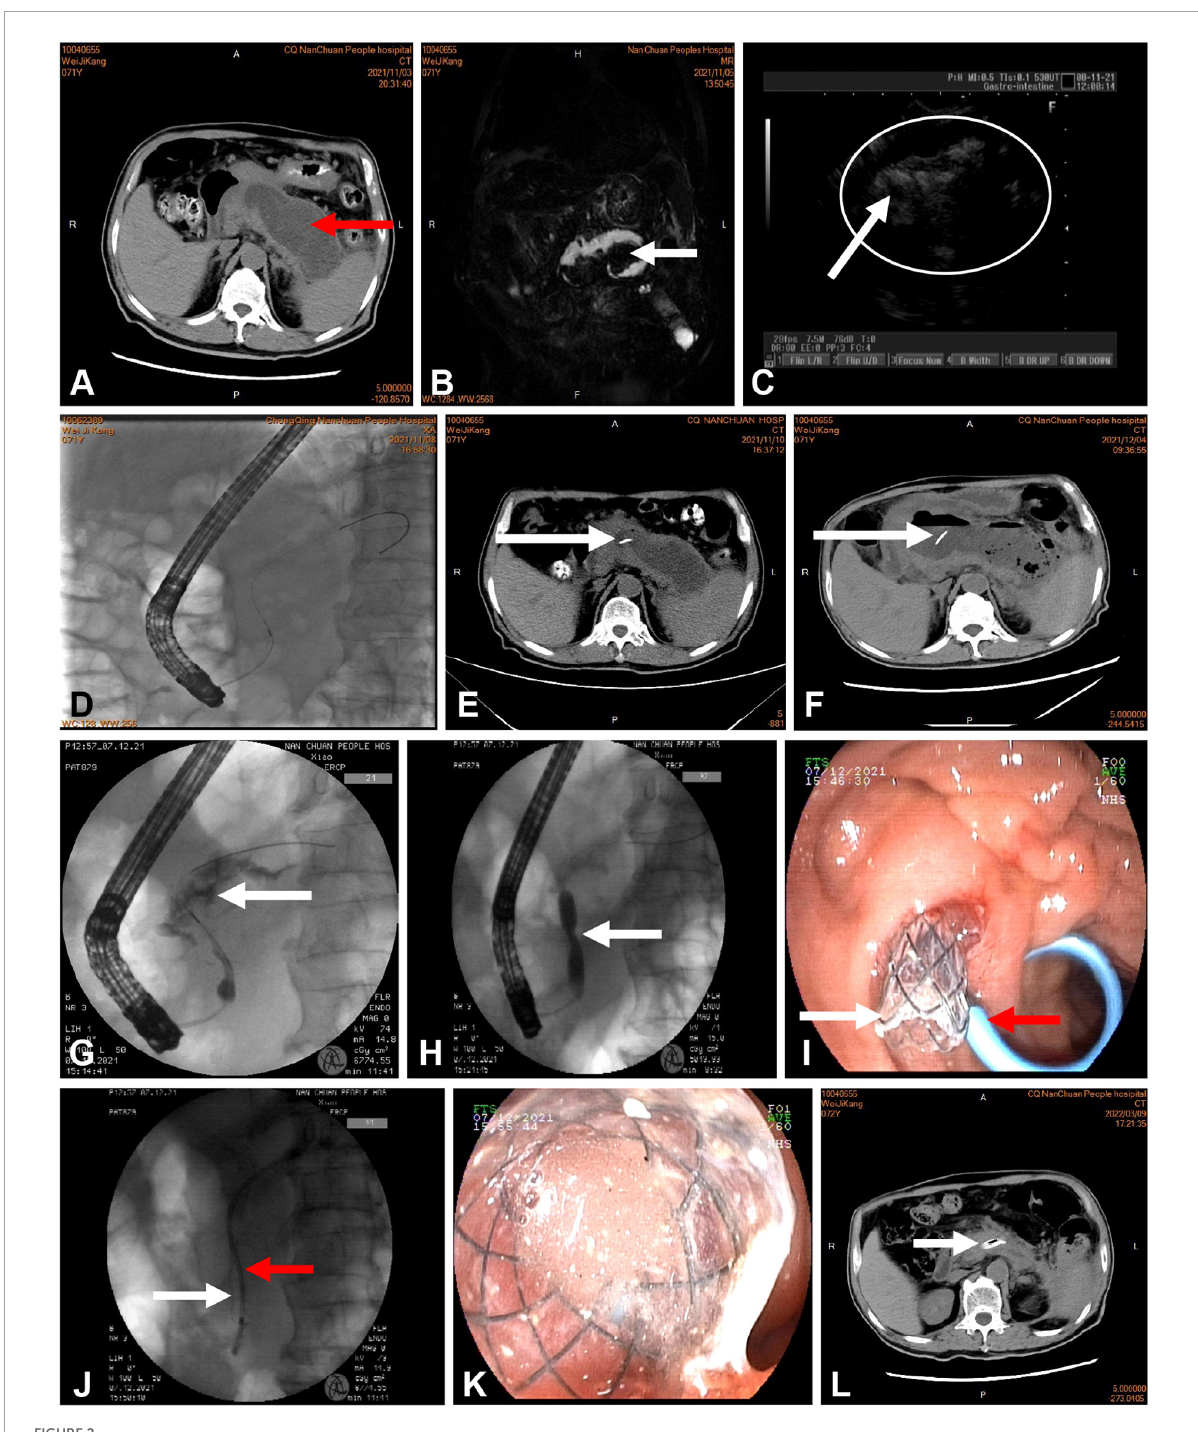
FIGURE2 (A) Computed tomography (CT) of the abdomen showing more than 50% pancreatic parenchymal necrosis and pancreatic fluid collection 102 mm in diameter (red arrow). (B,C) Rich debris was present in the cavity, as shown by magnetic resonance cholangiopancreatography (MRCP) (white arrow) and endoscopic ultrasound (white circle). (D) Endoscopic retrograde cholangiopancreatography (ERCP) showing a disrupted pancreatic duct communicating with the WOPN. (E,F) CT showing a plastic stent (white arrow) communicating with the WOPN. (F) The cavity was not reduced at 4 weeks after intervention. (G) ERCP showing extravasation of contrast material (white arrow) from the region of the pancreatic neck. (H) Balloon dilation of the pancreatic duct stenosis (white arrow). (I,J) Deployment of a metal stent (white arrow) and a plastic pancreatic stent (red arrow) inside the WOPN. (K) Drainage of necrotic tissue and fluid from the metallic stent. (L) CT performed 3 months after the end of active drainage. In the main pancreatic duct, the transpapillary metal and plastic pancreatic stents were